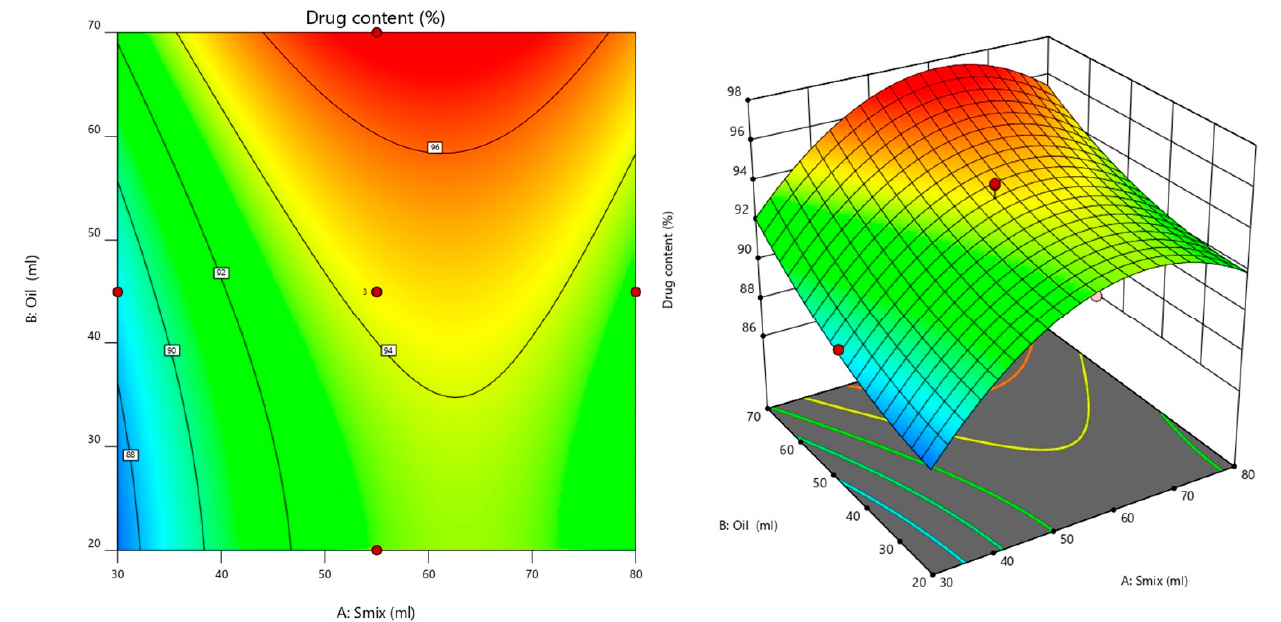
Figure 5. Contour plot and response surface plot for the effect of factors on drug content.